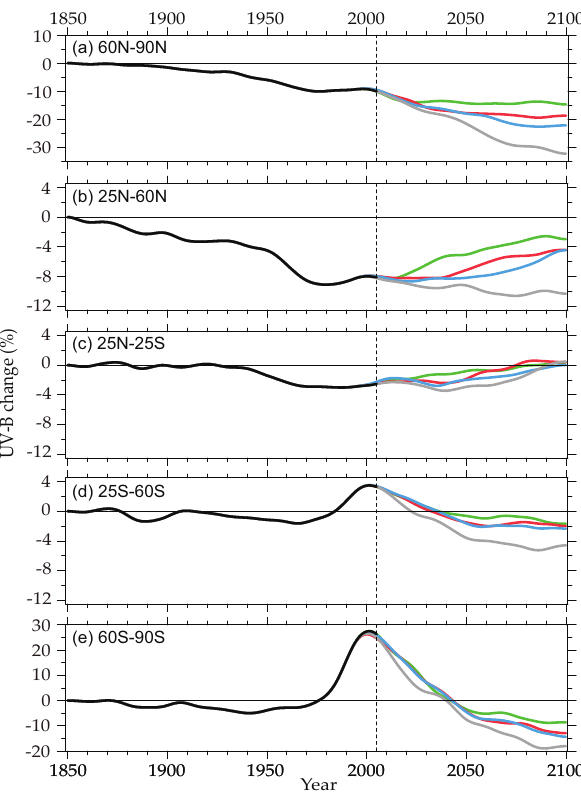
Fig. A1. Long-term evolution of the annual mean surface all- sky UV-B radiation simulated by MIROC-ESM-CHEM. Relative change to the 1850–1859 average is shown. Black curves show the results of the HIST simulation with full historical forcing. Green: RCP2.6, Red: RCP4.5, Blue: RCP6.0, and Gray: RCP8.5 simula- tions. In order to focus on the long-term tendency in UV-B, the original time series were smoothed with a 1-2-1 filter applied 60 times. Note that the range of vertical axes in (a) and (e) is different from